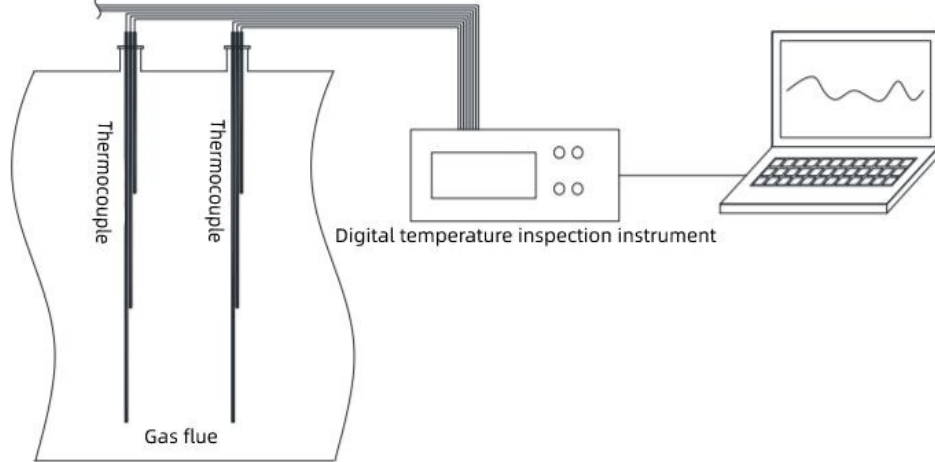
Figure 6. Layout of flue gas temperature measuring equipment.